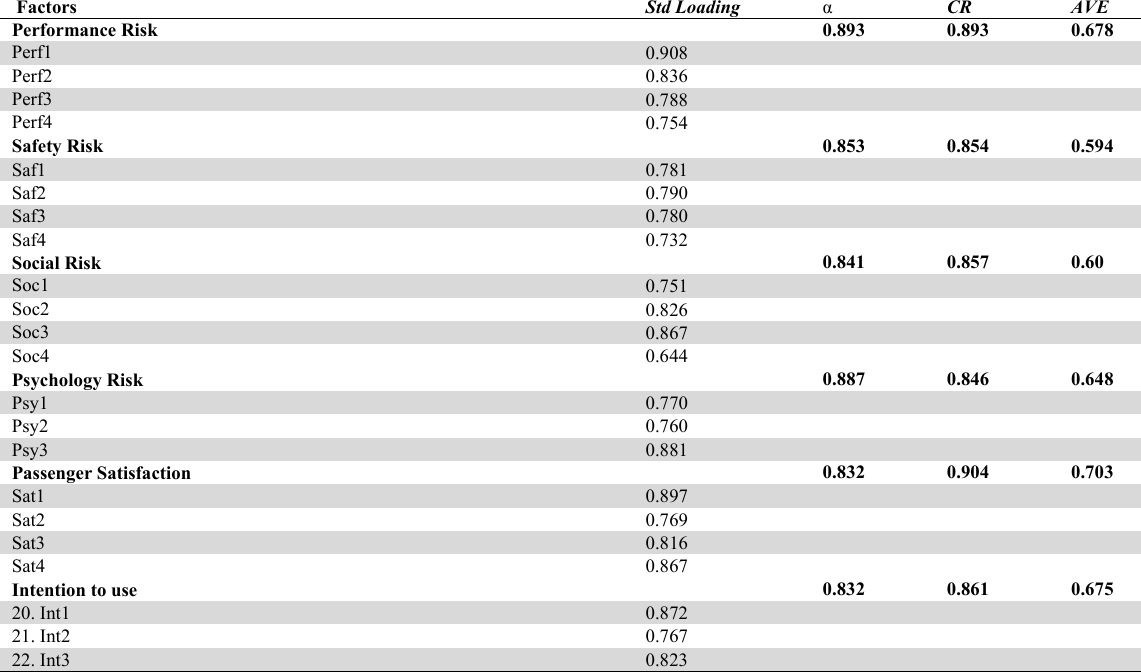
Analysis of measurement